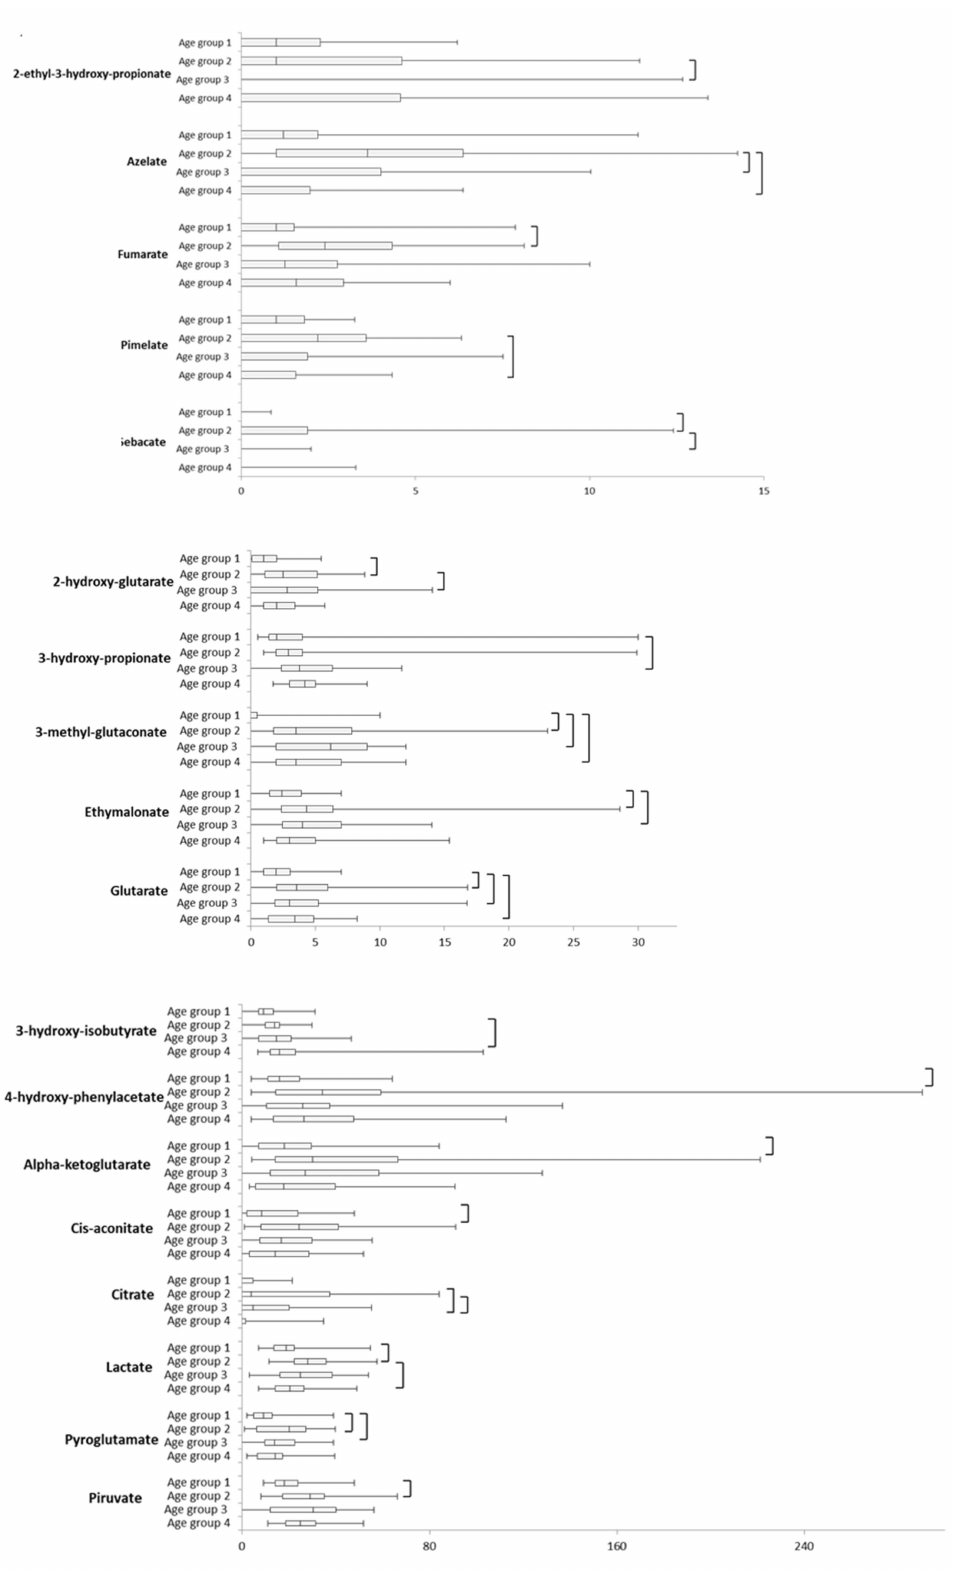
Figure 2. Box plot of age e ff ect on urinary organic acids (mmol / mol creatinine) in female cohorts. The vertical line across the box represents the median, and the box comprises the first and the third quartiles. The horizontal lines represent the minimum and the maximum values. Connectors represent a p < 0.05. Sample size for each age group was reported in the method